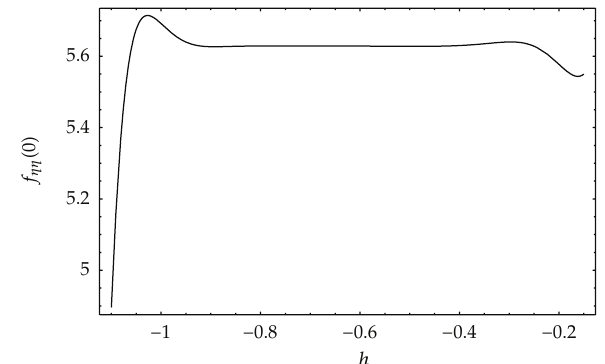
Figure 2: The h curve of f (cid:5)(cid:5) (cid:5) 0 (cid:6) at 20th order of approximation for m (cid:8) − 3 / 5 , M (cid:8) 3 and δ (cid:8) 3.